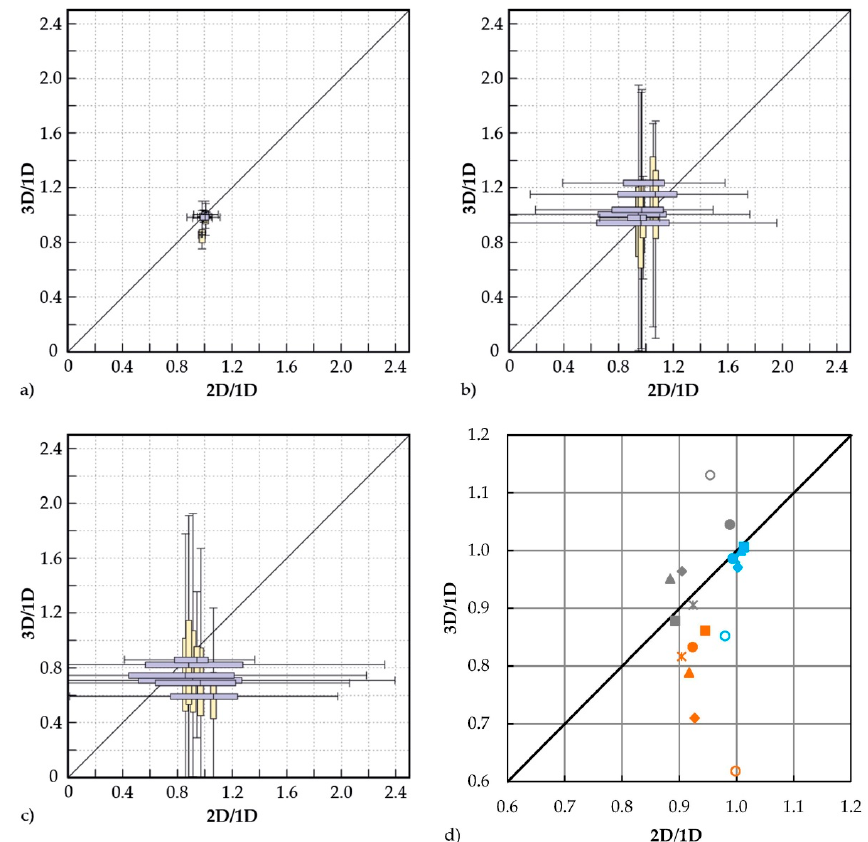
Figure 5. Relative comparison of the modeling results of ( a ) water depths, ( b ) depth-averaged flow velocities and ( c ) bed shear stresses consisting of ratios between 3D and 2D values, referring to 1D values depicted in box-plots for each case study and discharge scenario; ( d ) Average ratio between 3D and 2D values, referring to 1D values for water depths (blue), flow velocities (grey) and bed shear stresses (brown) depicted for each case study and discharge scenario (C.1 (*), C.2- 𝑄 (cid:3013) ( ▲ ), C.2- 𝑄 (cid:3014) ( ♦ ), C.2- 𝐻𝑄 (cid:2869) ( ○ ), C.3- 𝑄 (cid:3013) ( ■ ), C.3- 𝑄 (cid:3014) ( ● )).